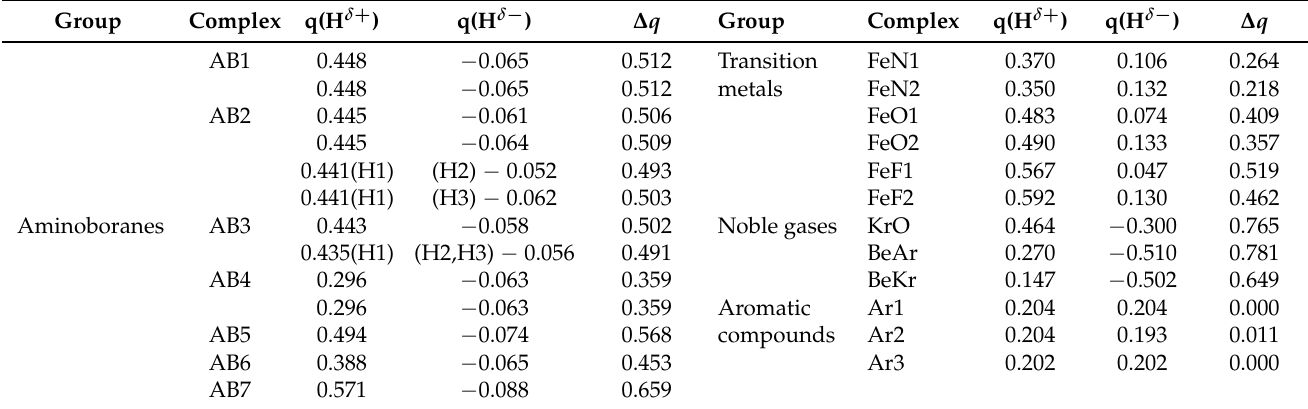
Table 2. Protonic and hydridic NBO charges (in e) for Group II–V. Protonic hydrogen charge q(H δ +